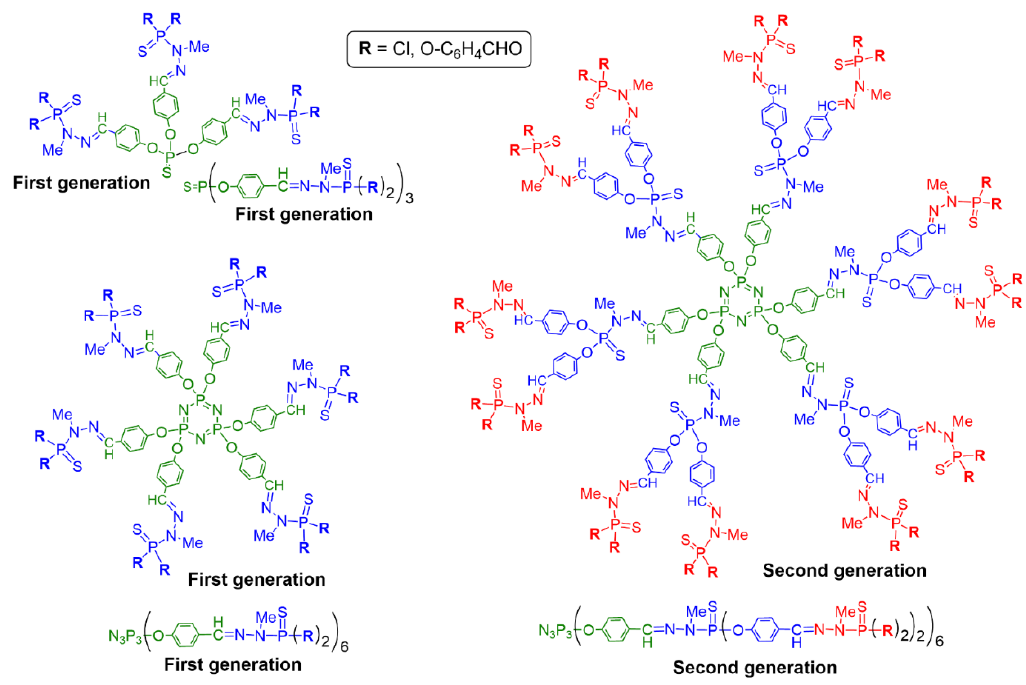
Figure 2. Two ways for drawing the 1st and 2nd generations of polyphosphorhydrazone dendrimers: full chemical structure, and linear structure with parenthesis after each layer of branching points.